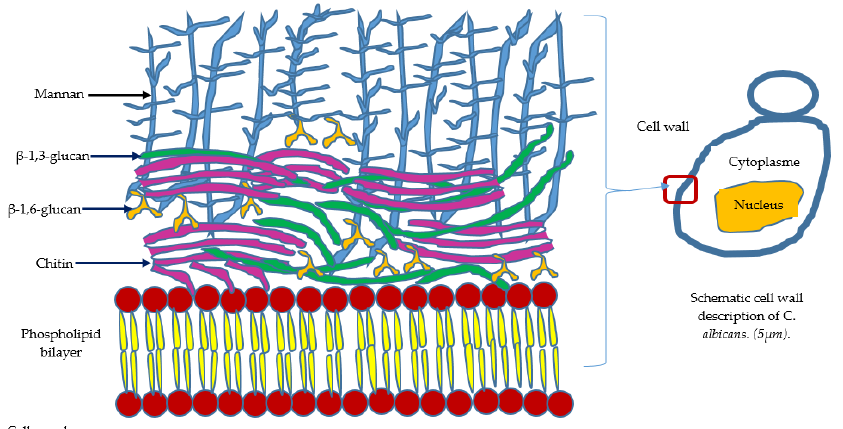
Figure 2. Pathogen-recognition receptors (PRRs) of the epithelial cell recognize different C. albicans PAMPs (pathogen-associated molecular patterns). Among PAMPS, on the outside of the Candida we find five layers within the cell wall. The outer layer is composed of C-linked proteins, mainly man- nan (85%). Below is the β -1,6- glucan, the β -1,3-glucan, and the chitin layers. Underneath is a double layer of phospholipid framed by a membrane protein. PAMPs and mannan can be recognized by the PRRs of epithelial cells (Dectin-2, DC- SIGN, MINCLE, and TLR2/4/6). PAMPS, β -glucan, and chitin can be recognized by PRRs (Dectin-1, CR3, and NOD2, TLR4).